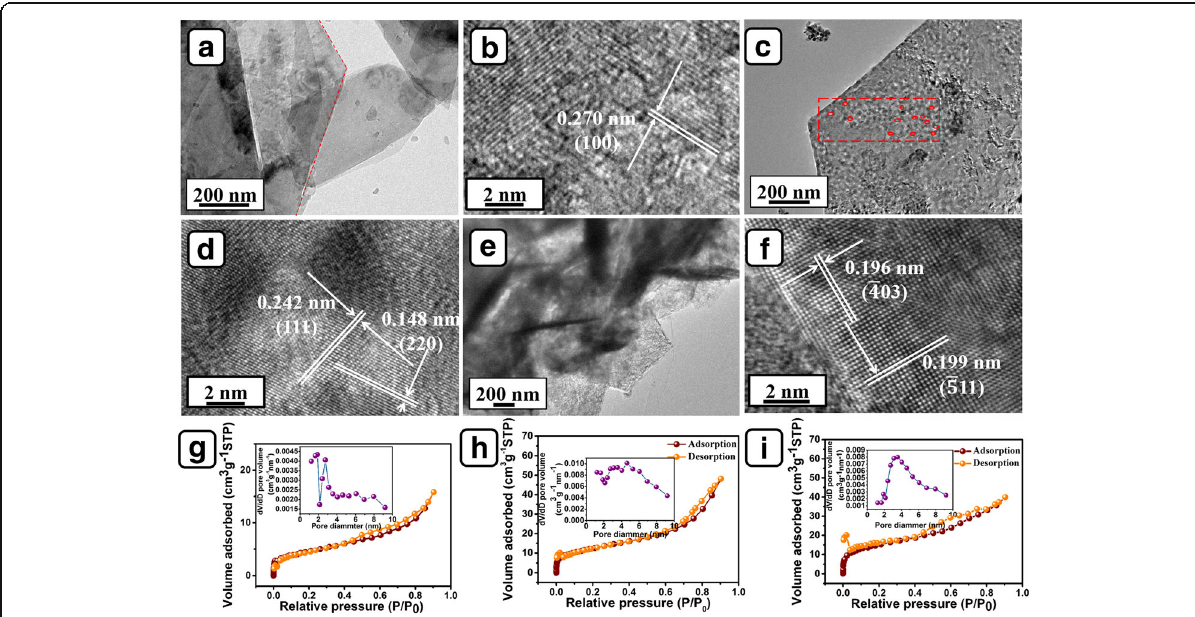
Fig. 4 HRTEM images of a , b Ni(OH) 2 flakes, c , d NiO flakes, e , f NiO flakes@CoMoO 4 NSs; g – i are the nitrogen adsorption-desorption isotherms of Ni(OH) 2 flakes/NF, NiO flakes/NF, and NiO flakes@CoMoO 4 NSs/NF, respectively. Insets of ( g – i ) are the corresponding pore size